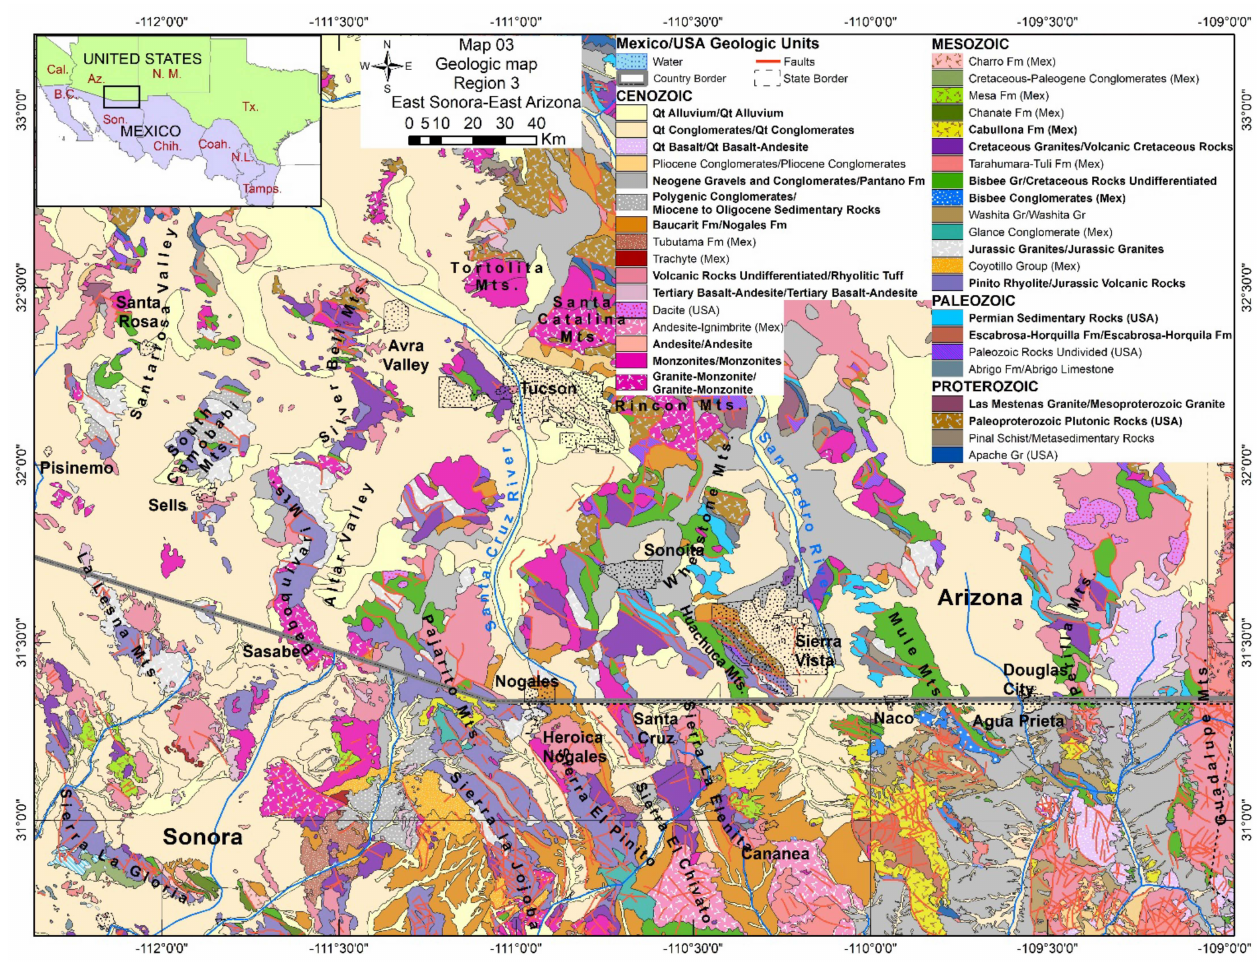
Figure 3. Geologic map, East Sonora—East